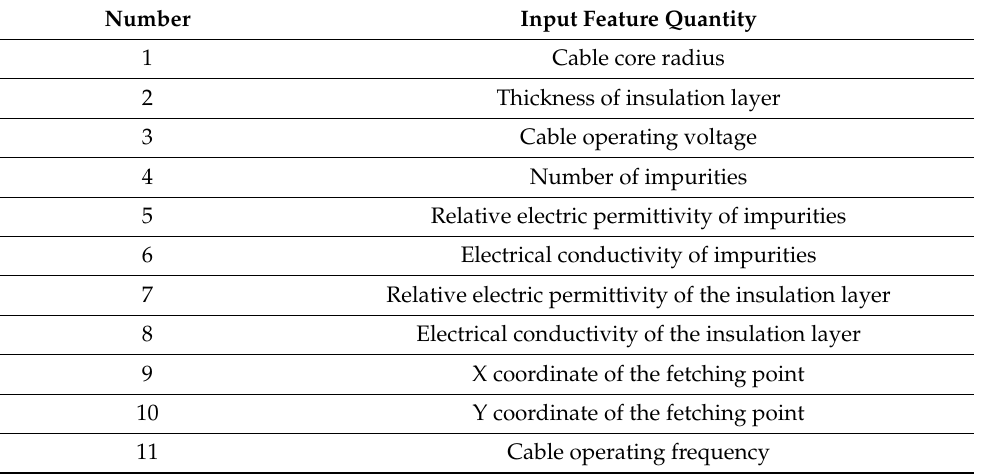
Table 2. Input feature